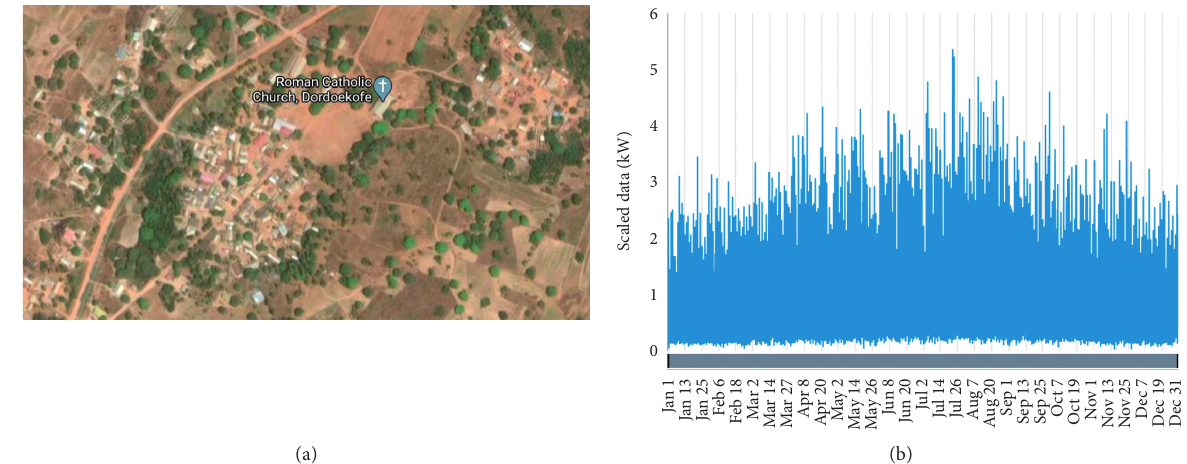
Figure 3: (a) Remote community in the south-eastern part of Ghana. (b) Daily load profile of the selected community at